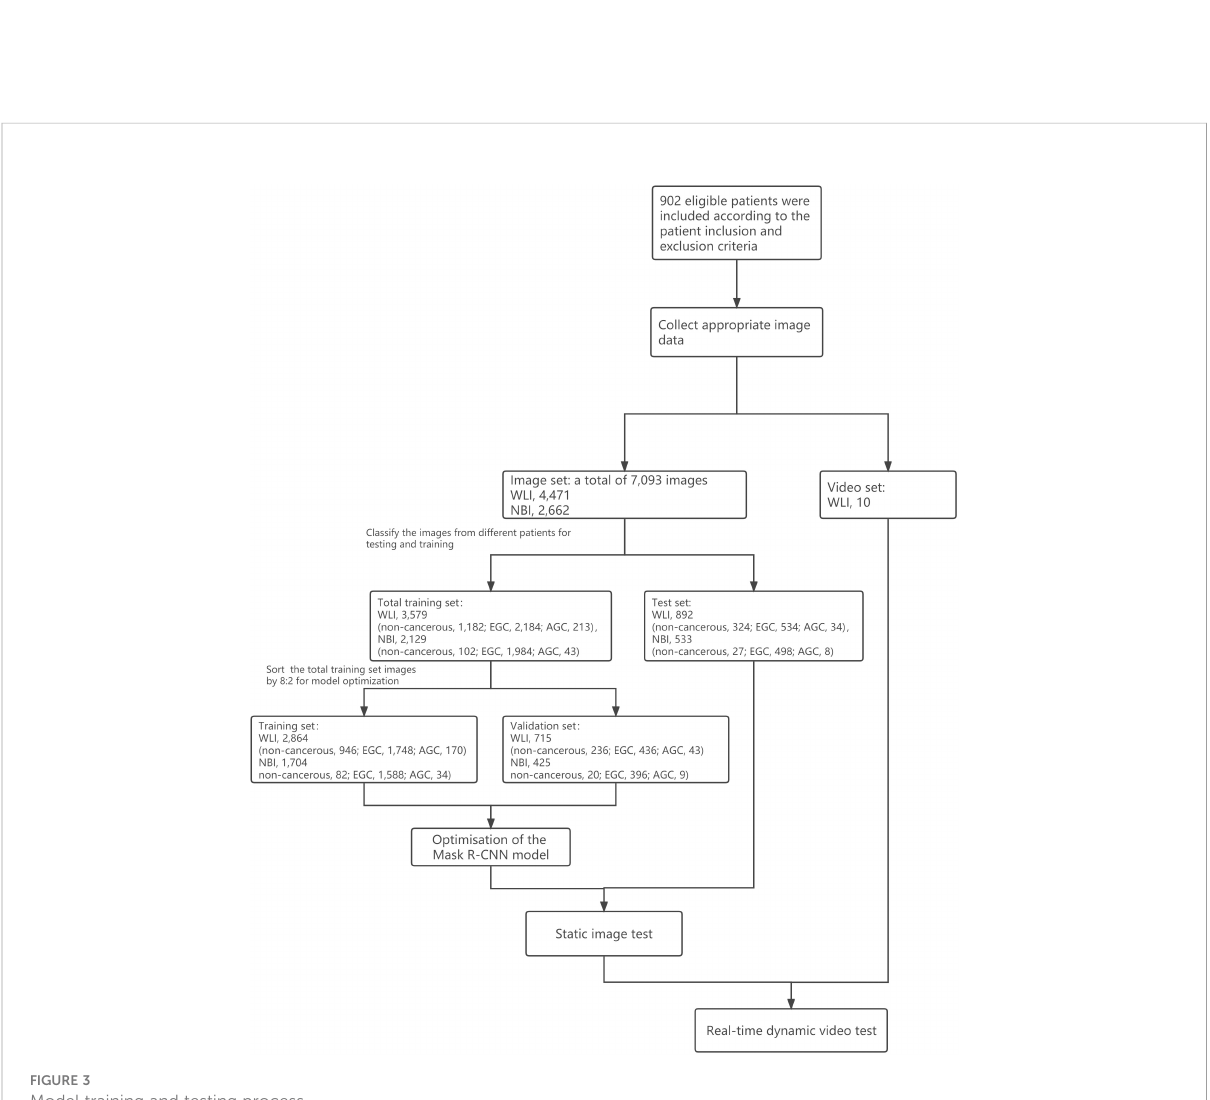
FIGURE 3 Model training and testing process.